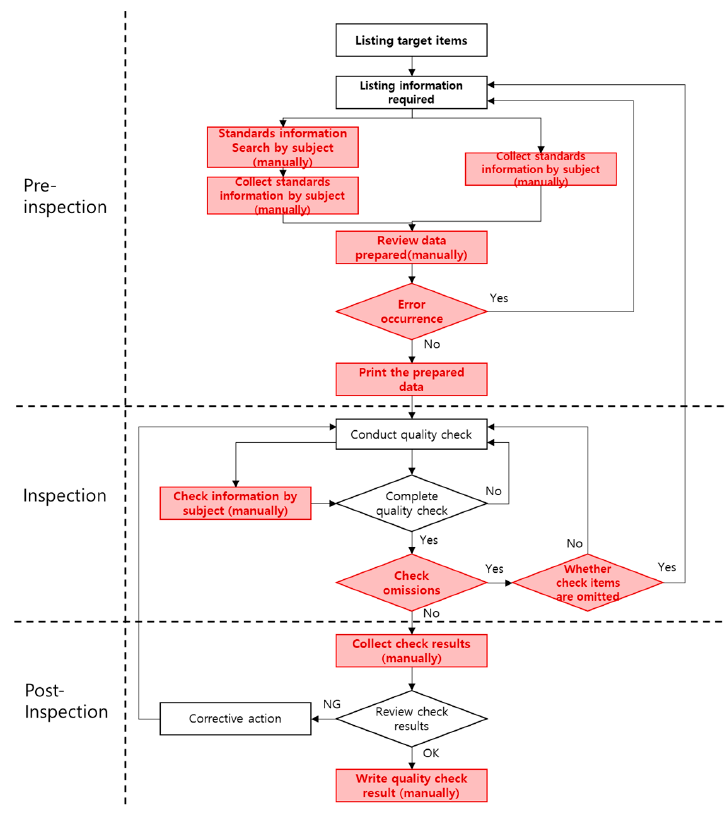
Figure 1. Current TCW quality inspection work process.